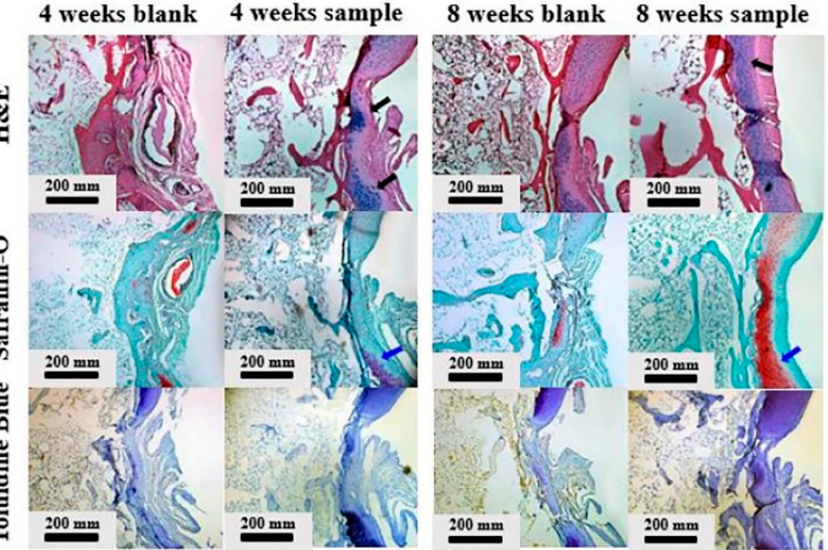
Figure 4. Histological images of an in vivo model at 4 weeks and 8 weeks (scale bar = 200 mm). The black arrows indicate well-formed new tissue. The blue arrows indicate red Safranin-O staining, which dyes an acidic proteoglycan. Reprinted from Kim et al. [38]. Copyright (2019), with permission from Elsevier.